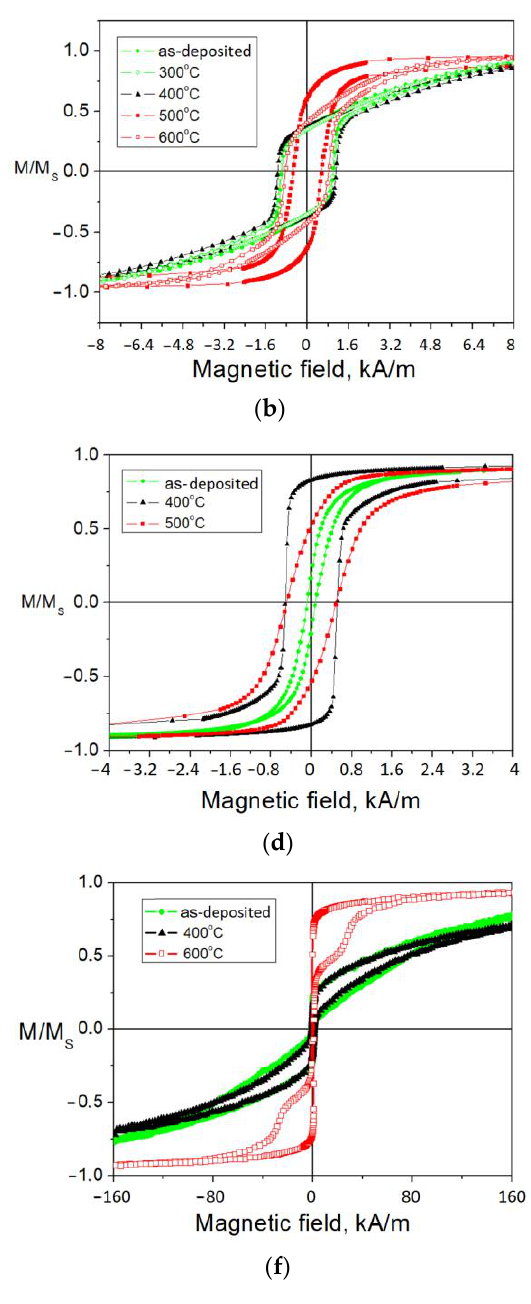
Figure 9. The hysteresis loops of the films I ( a ), II ( b ), III ( c ), IV ( d ), V ( e ), VI ( f ) in the as-deposited state and after annealing.